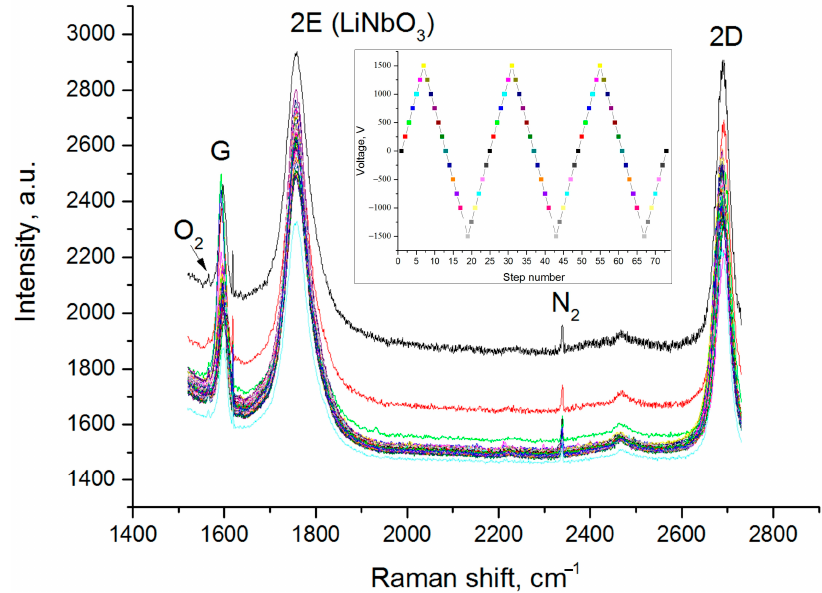
Figure 2. Experimental Raman spectra from graphene on the substrate of a Z-cut lithium niobate single crystal, obtained at various electrical voltages (peak near G: instrument artifact). The inset shows the change in applied voltage. The color of the dots in the inset corresponds to the color of the spectrum in the main plot.